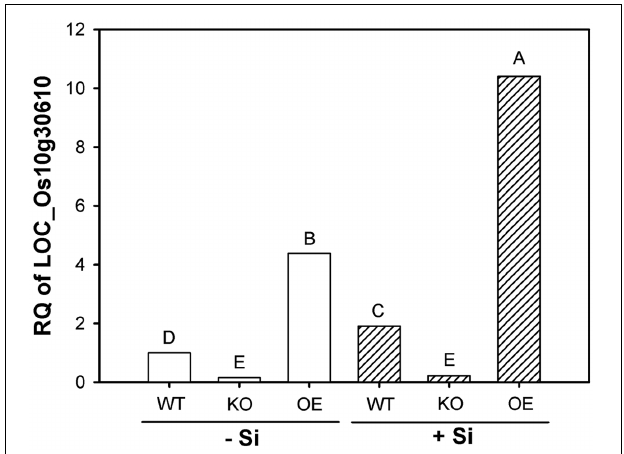
FIGURE 1 | Transcription of the gene LOC_Os10g30610 (OsABCG25) in root zone 4–6 cm of wild type (WT), knockout (KO) line 1B-14436 and overexpression (OE) line 3A-16329 (OE) plants grown in nutrient solution with low (–Si, 3 mg Si L − 1 ) and high (+Si, 30 mg L − 1 ) Si supply. Relative quantity (RQ) of WT –Si = 1. Different letters indicate significant differences between treatments at p < 0.01.